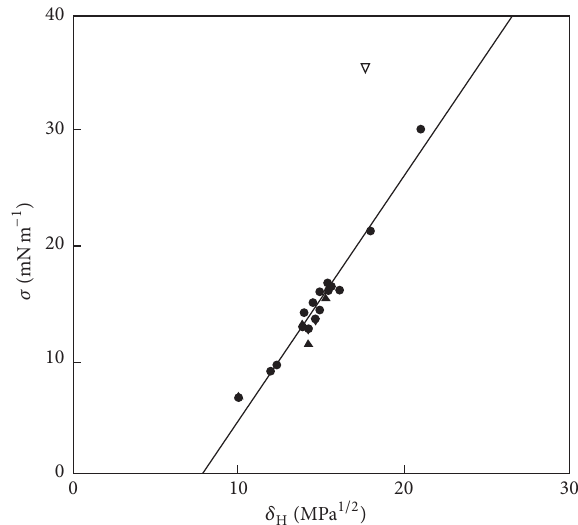
Figure 2: The surface tension of liquefied gases at their boiling points, 𝜎 / mNm −2 , plotted against their solubility parameters, 𝛿 H / MPa 1/2 . The symbols are for the surface tension from [16, 17] e , from [18] 󳵳 , and [19] 󳶃 , and for the outlier (CH 3 ) 2 O, 󳶚